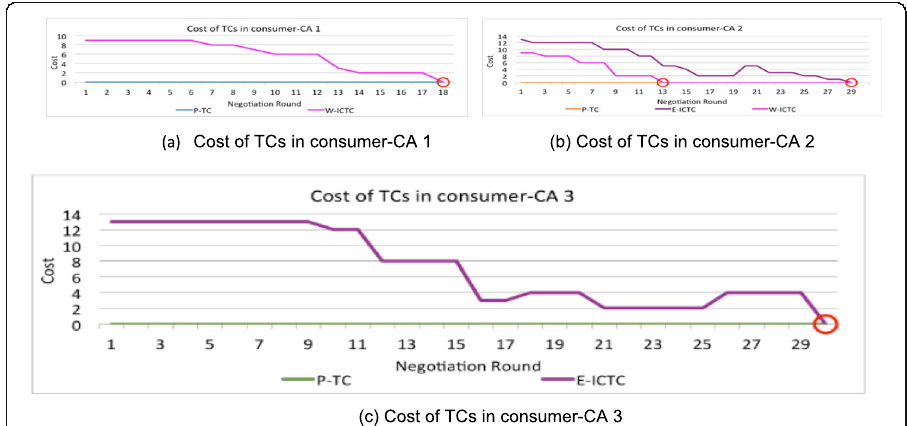
Fig. 12 Cost of TCs in cosumer-CAs during inter-CA negotiation. a Cost of TCs in consumer-CA 1. b Cost of TCs in consumer-CA 2. c Cost of TCs in consumer-CA